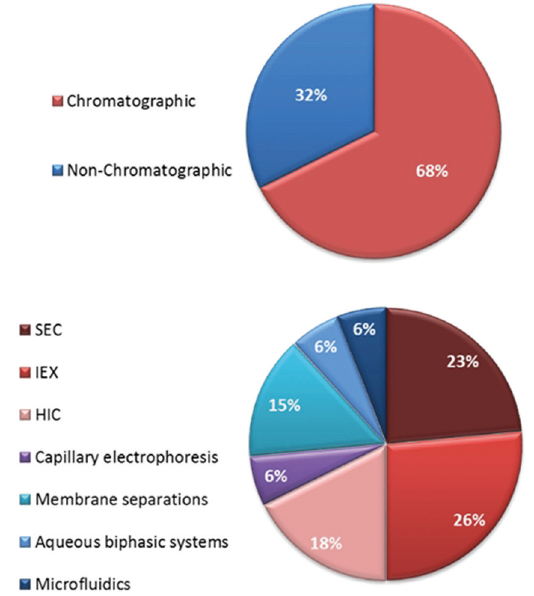
FIGURE 10 - Distribution of the publications/papers reported in the last 7 years (> 2010) dealing with chromatographic and non- chromatographic techniques for the separation of PEGylated proteins in Web of Science and Pubmed databases. SEC – size exclusion chromatography, IEX – ion exchange chromatography, HIC – hydrophobic interaction